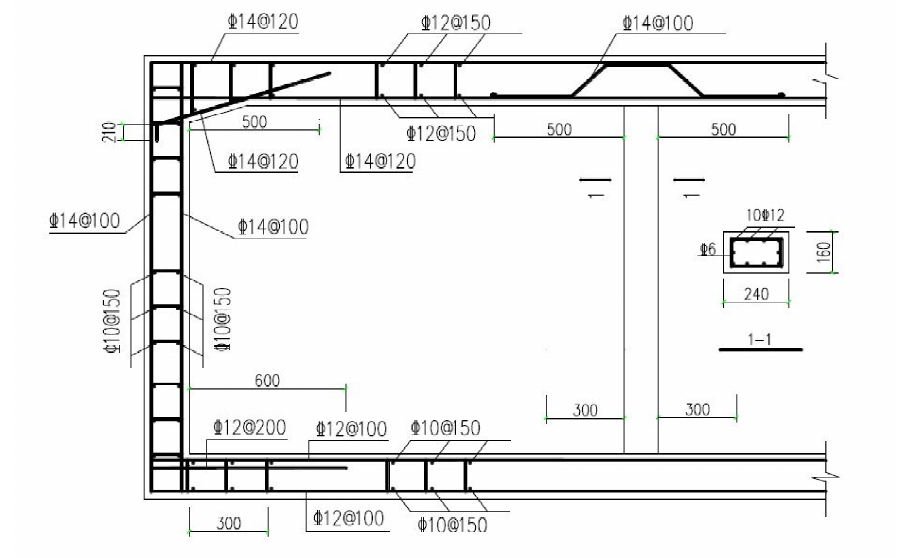
Figure 4. Reinforcement drawing of the tested structure (mm), taken from